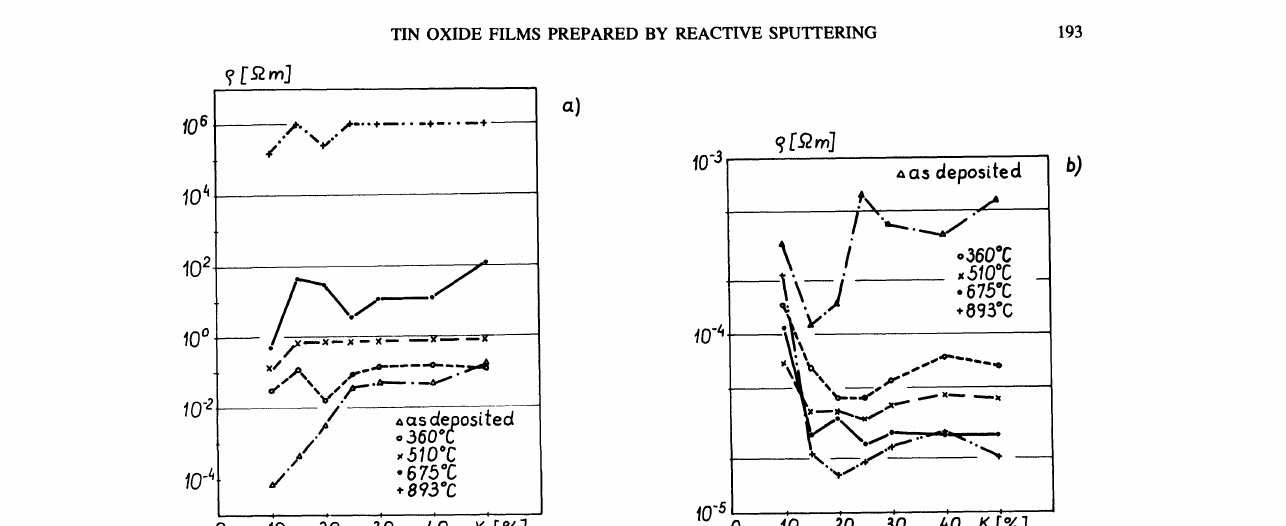
FIGURE Resistivity as a function of oxygen content K during sputtering before and after each step of annealing: (a) undoped; (b) Sb-doped films. measurements ofthree resistors for each K value. In the case ofundoped films the sharp increase in the resistivity was observed. The changes in the range of one to two orders of magnitude were obtained for each stage of annealing up to 675C. However, after the last stage of annealing the films became non-conducting. The limit of the electrometer measurements was of about 106 f.m.